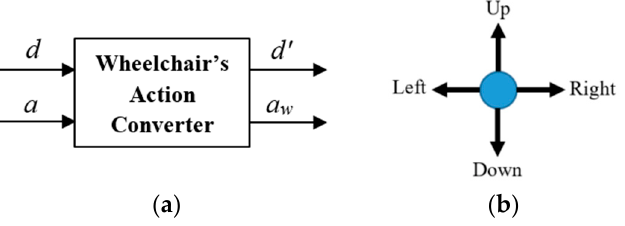
Figure 7. The representation of converting actual control commands from the simulation. ( a ) Con- verter with the simulated inputs and the actual outputs; ( b ) representation of four control directions.